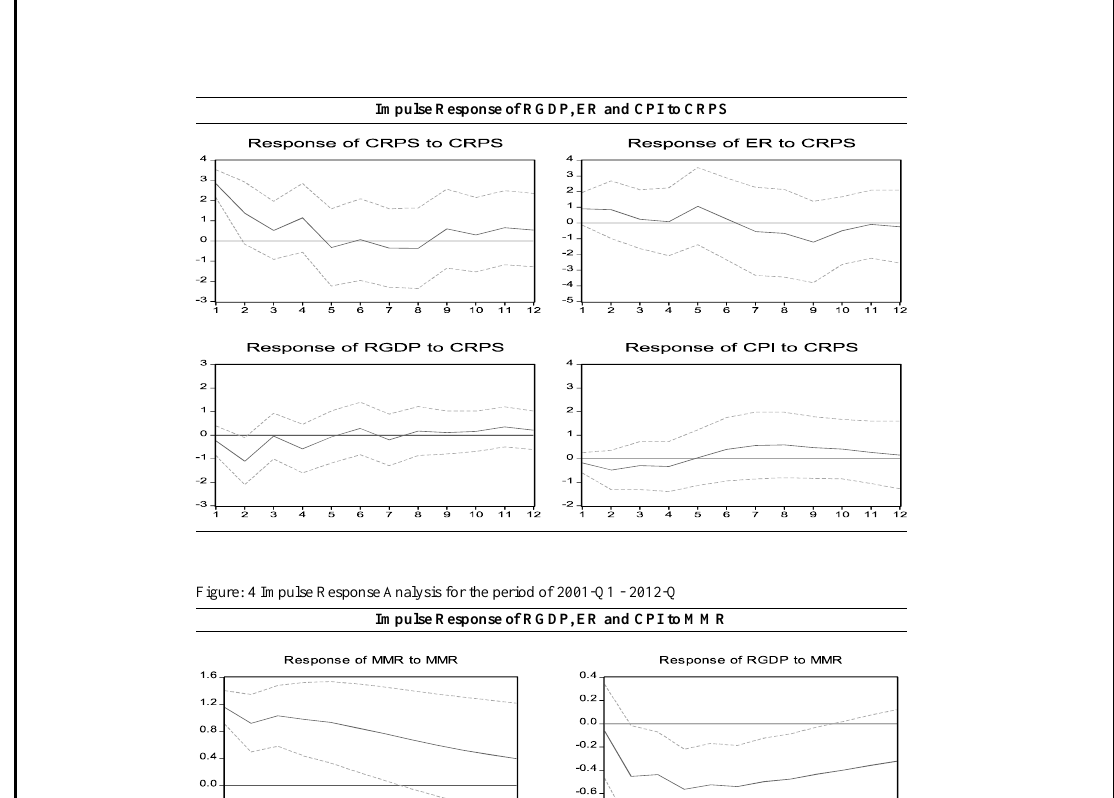
Figure: 4 Impulse ResponseAnalysis for the period of 2001-Q1 - 2012-Q Impulse Response of RGDP, ER and CPI to